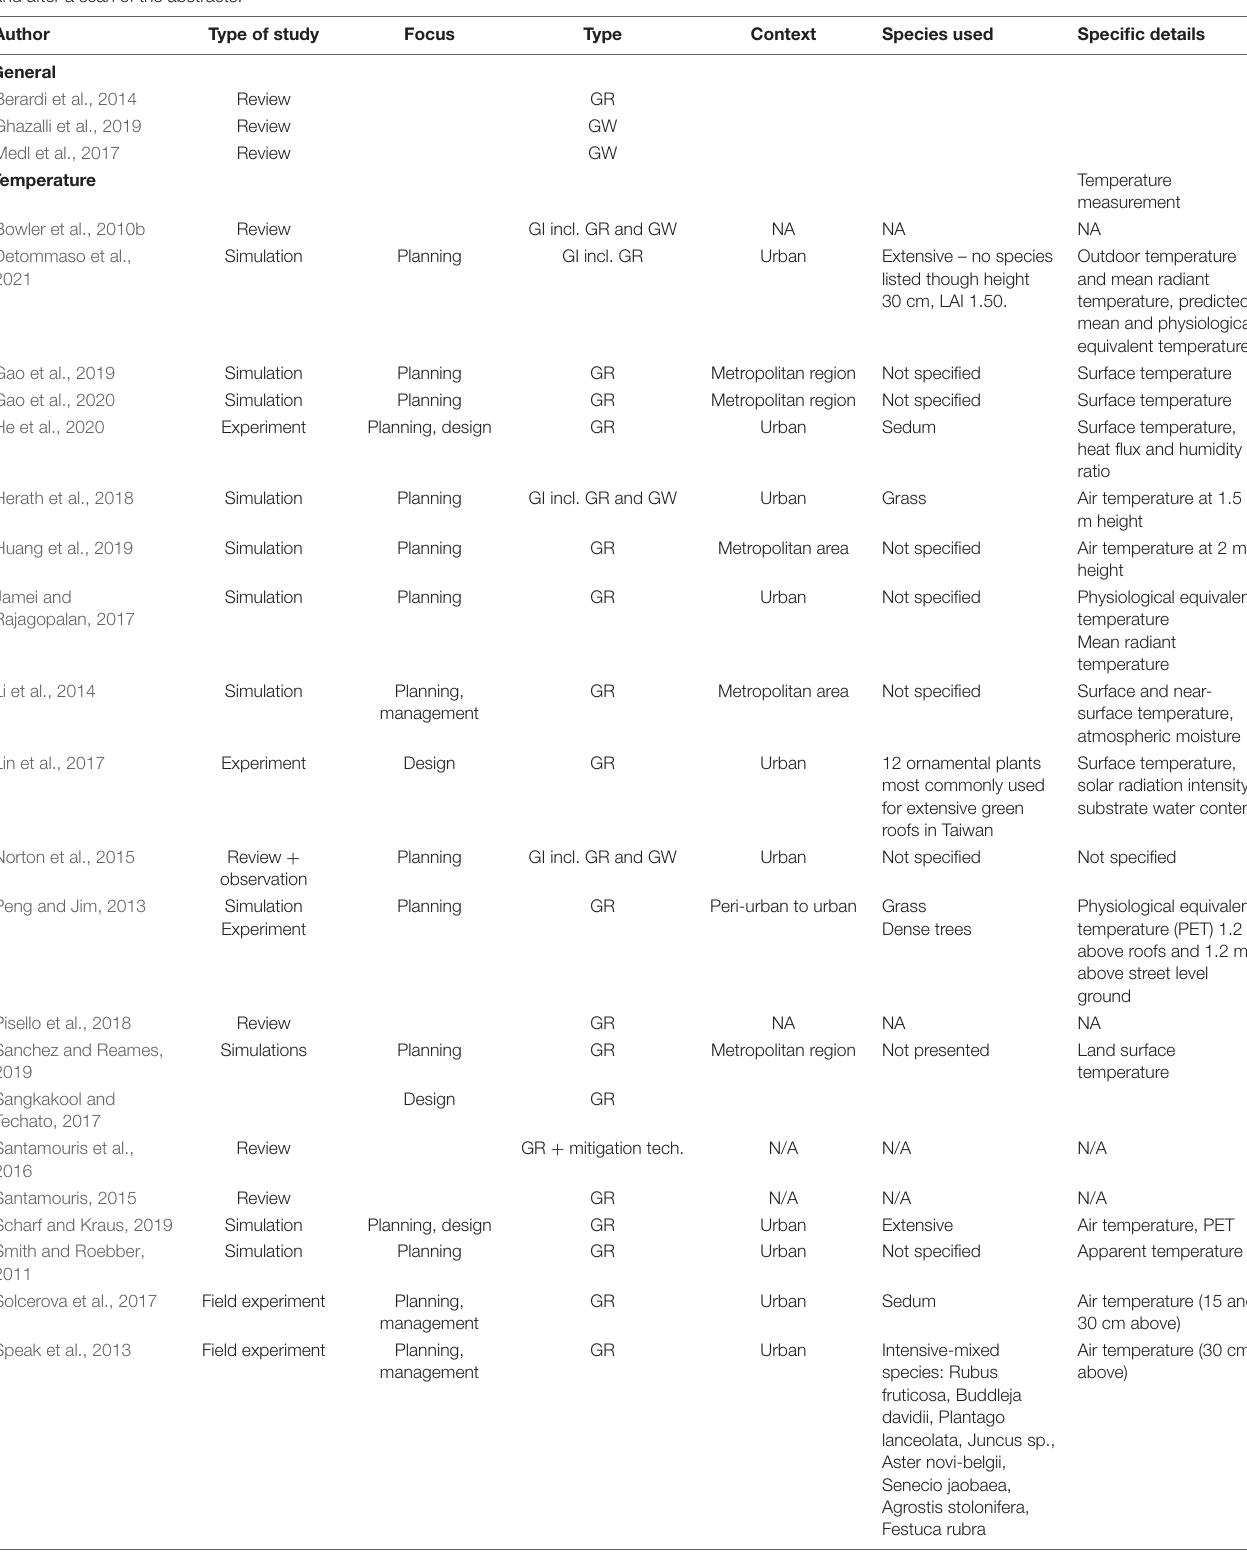
TABLE 2 | Articles ( n = 69) recovered through a search in Scopus using the terms “green roof” OR “green wall” AND health OR wellbeing OR well-being OR aesthetic and after a scan of the